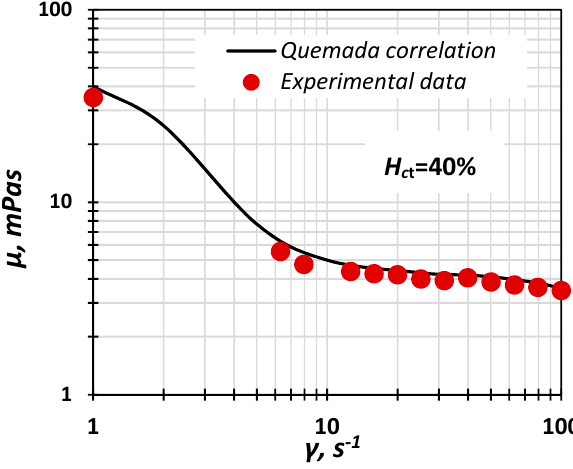
Figure 1. Experimental data of “ blood ” viscosity vs. shear rate compared with the Quemada correlation ( H ct = 40%).